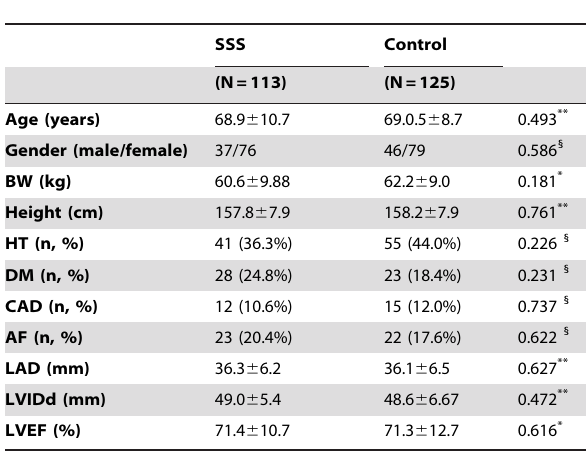
Table 1. General characteristics of patients included in the